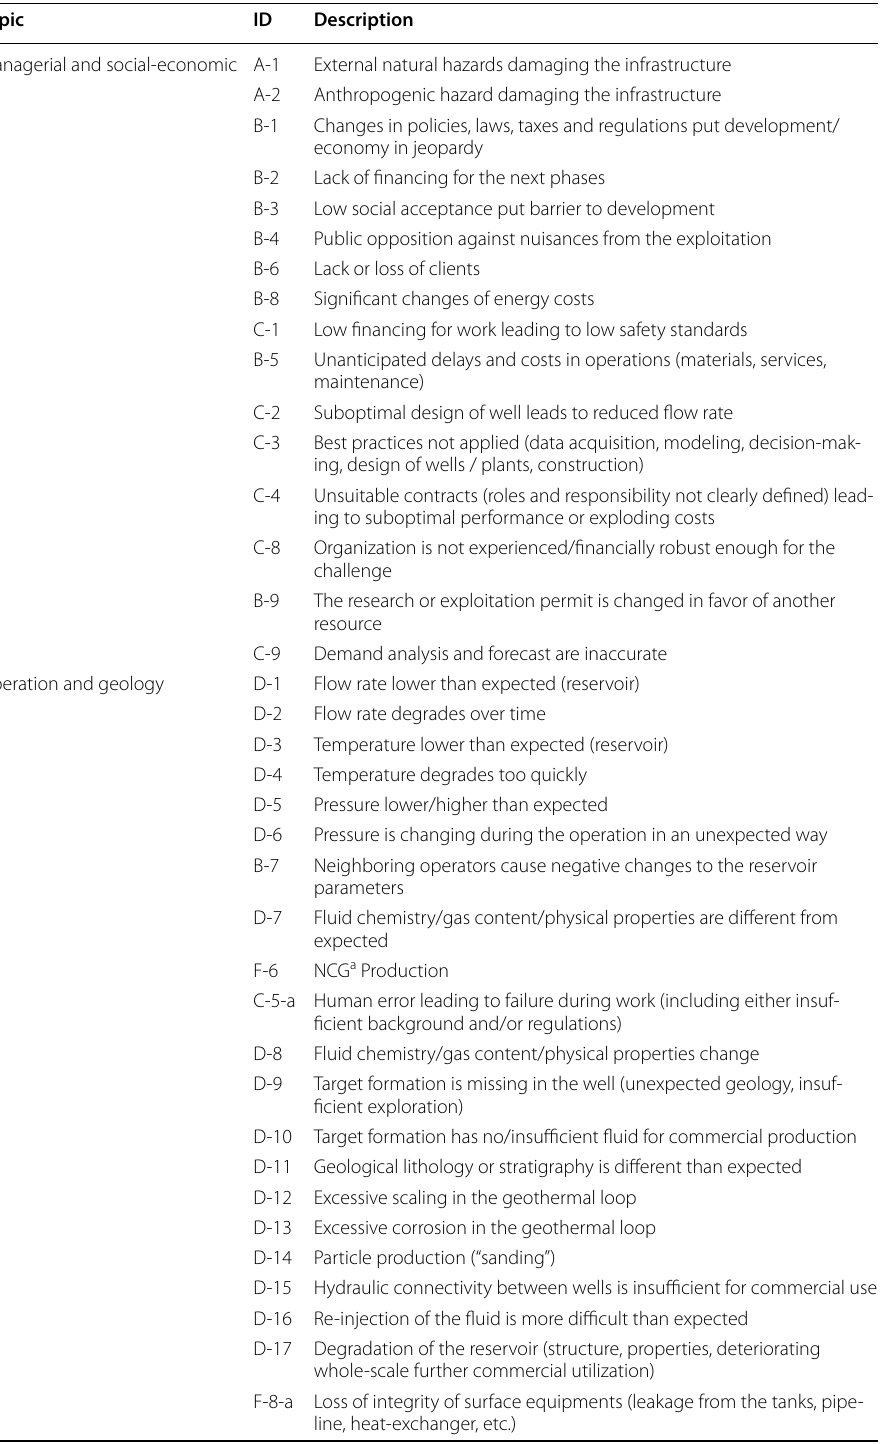
Table 1 List of risk sorted by topic. The ID of each risk is indicated Topic ID Description Managerial and social-economic